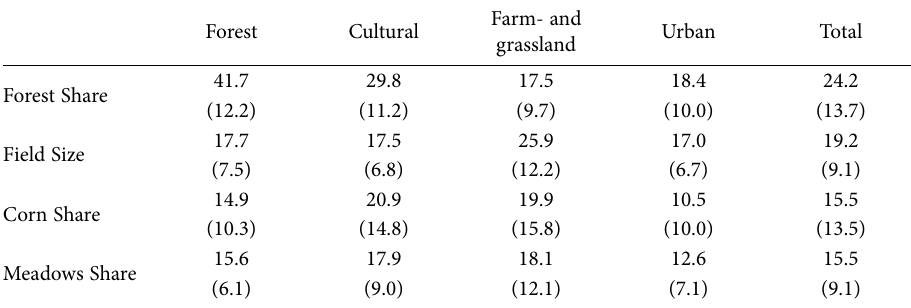
Table 4. Mean and standard deviation (in parenthesis) of actual status quo by landscape categories. Forest